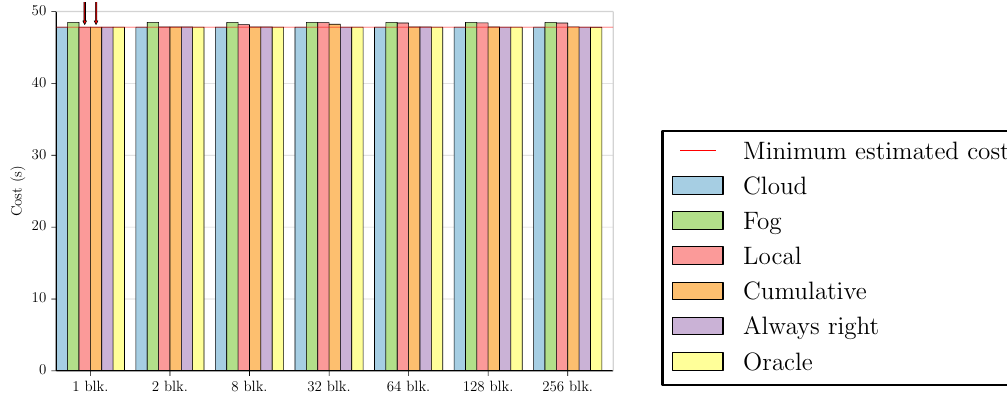
Figure 8. Summary of the results for Outlier 16 cloud-prone test cases